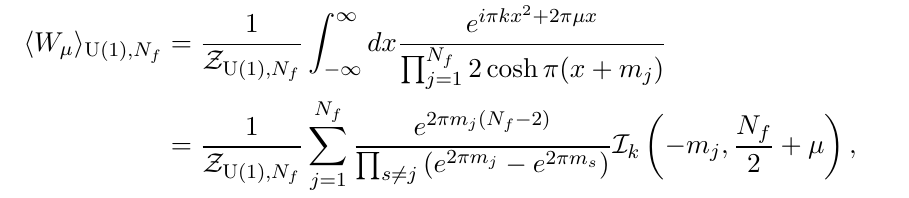
Figure 8 . Non-Abelian A 1 quiver with N f fundamental